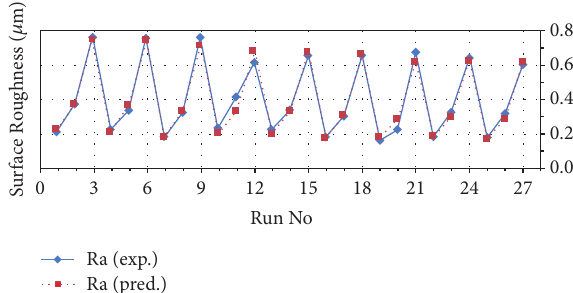
Figure 8: Comparison between predicted and measured values for surface roughness.